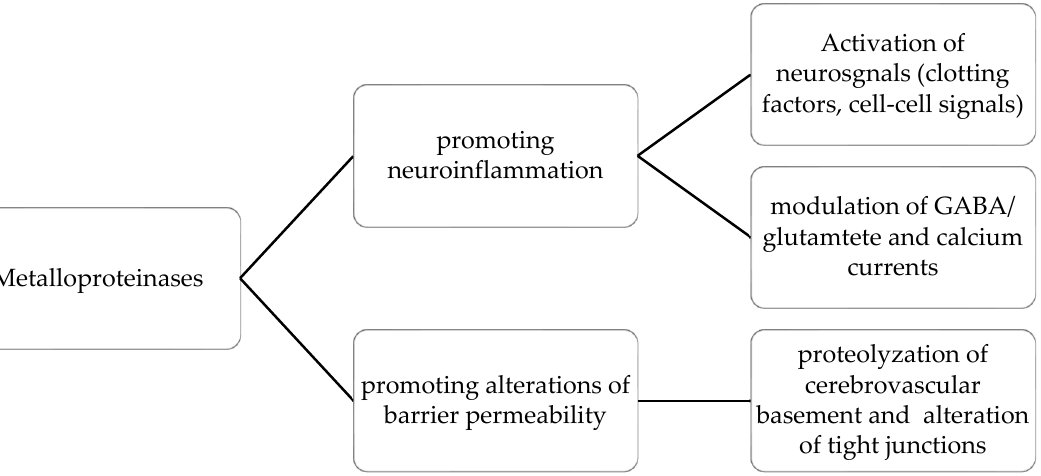
Figure 2. A synopsis of the metalloproteinases action inside the brain, redirecting in SVD pathology.